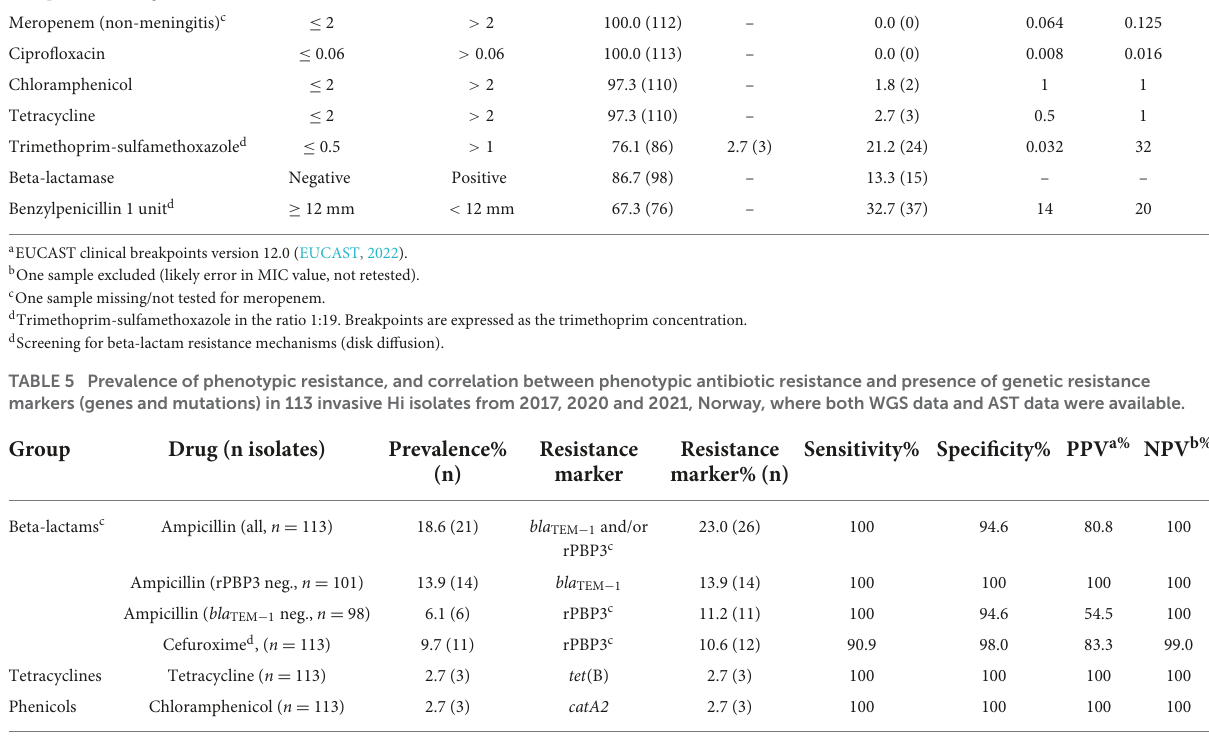
Trimethoprim-sulfamethoxazole d